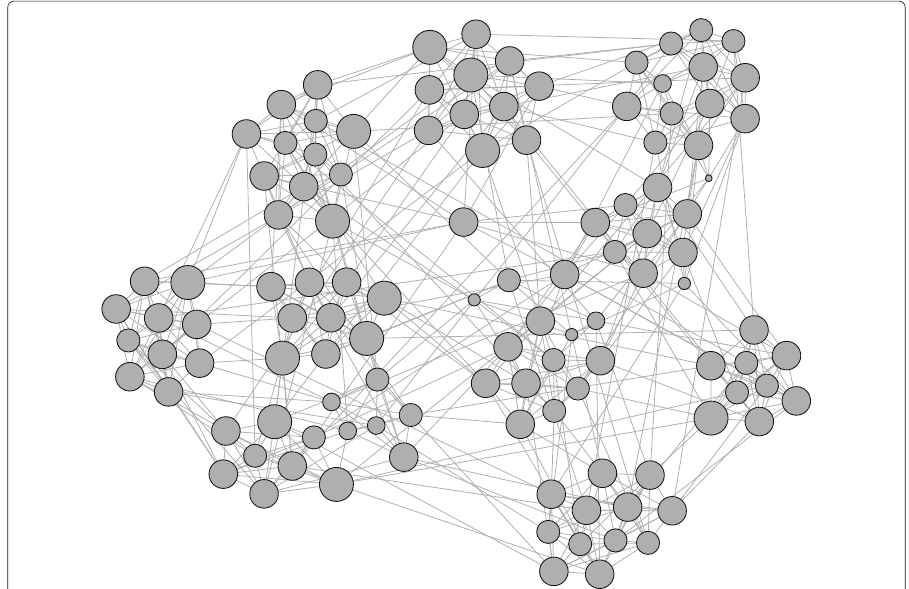
Fig. 8 The football network. Zones are not communities; no larger zones can be detected in the football network. It is evident that the network has a community structure. However, the network almost does not include central nodes in communities or centers linking communities; the node size is proportional to its degree and, as can be seen, most of the nodes have a similar